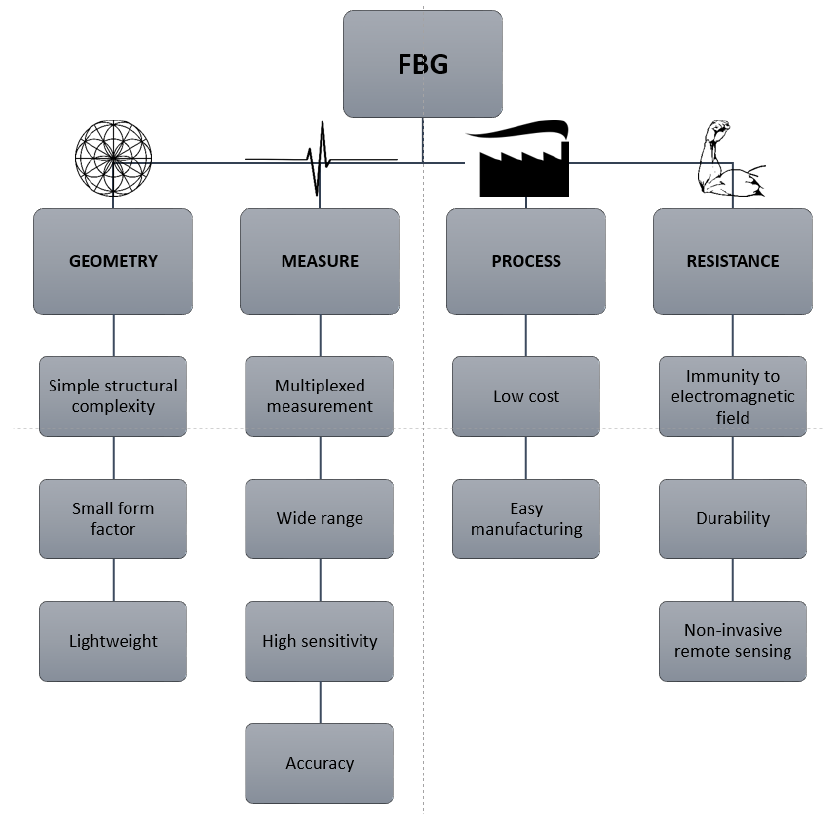
Figure 6. Fiber Bragg grating sensor characteristics [15,45,46].